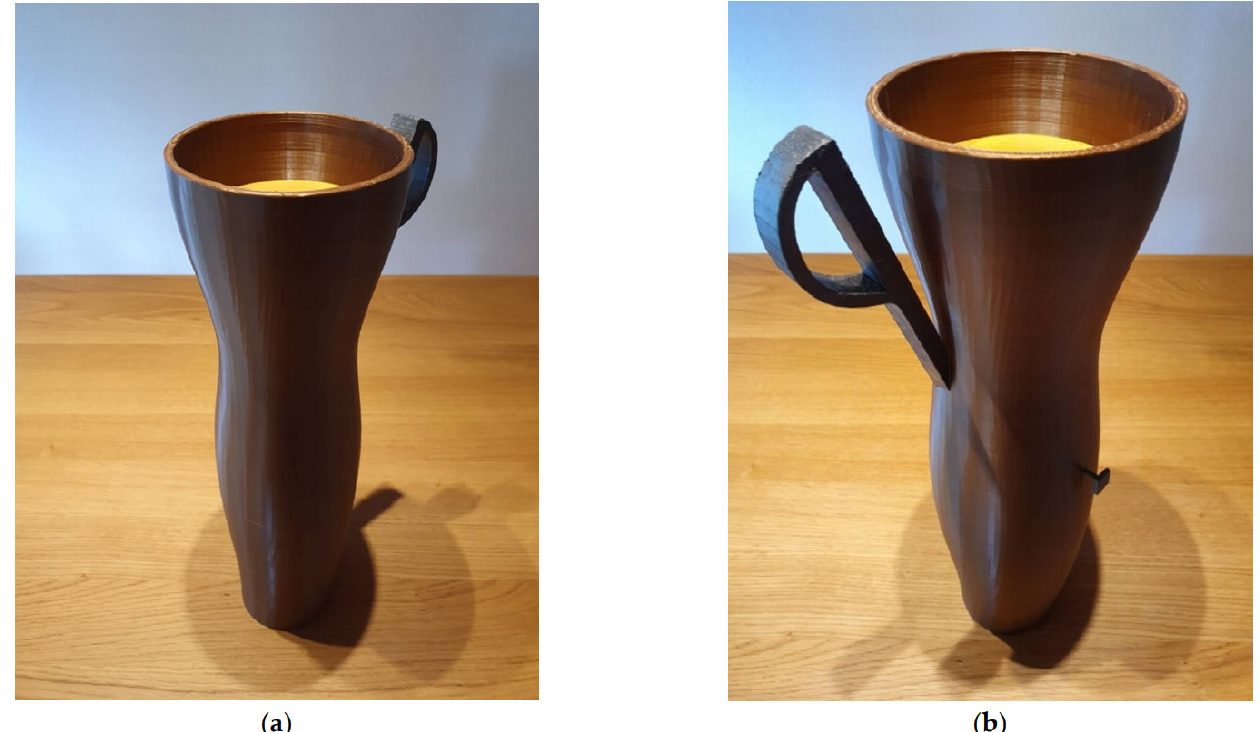
Figure 2. 3D print of the reconstructed Capua leg: ( a ) View from the front; ( b ) View from the